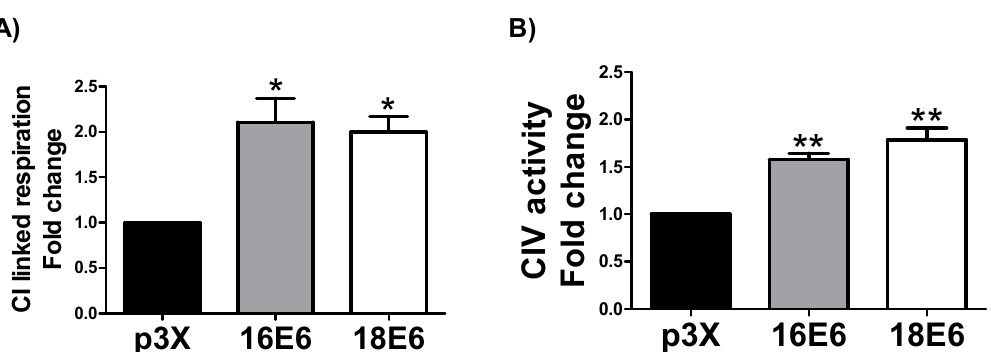
Figure 3. 16E6 and 18E6 oncoproteins promote the increase in mitochondrial electron transport system (ETS) activity in FaDu cells. ( A ) Complex I (CI) linked respiration; ( B ) Complex IV (CIV) activity. Data are expressed as the mean ± SD. Tukey’s test * p < 0.05 and ** p < 0.005 vs. p3X control, n = 3.